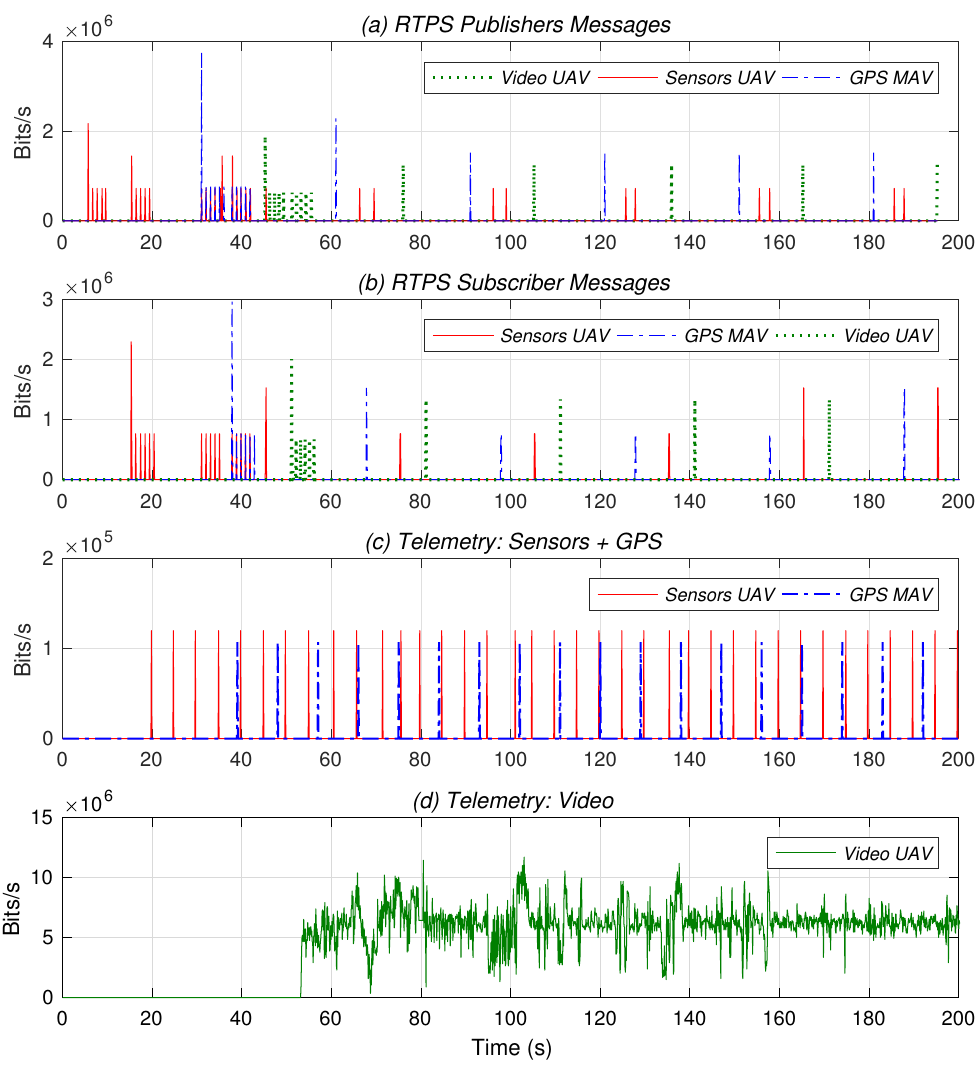
Figure 4. DDS signaling ( a , b ); and data exchange ( c , d ).